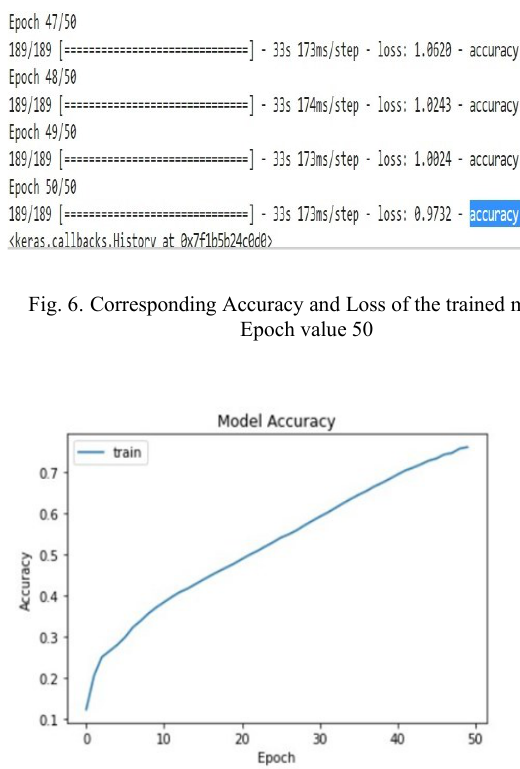
loss of the model decreases simultaneously.